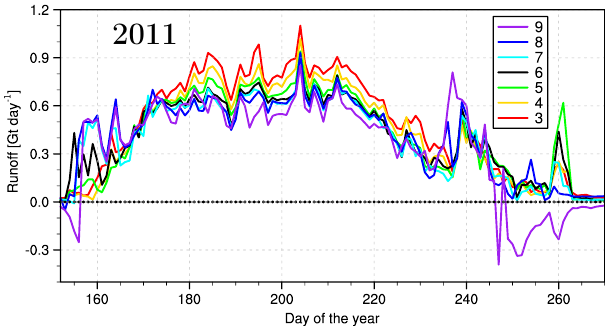
Figure 5. Summer 2011 time series of daily, ice sheet-integrated runoff difference (Gtday − 1 ) between the downscaled product at 1km, using a minimum threshold of three–nine regression points (legend), and the RACMO2.3 model at